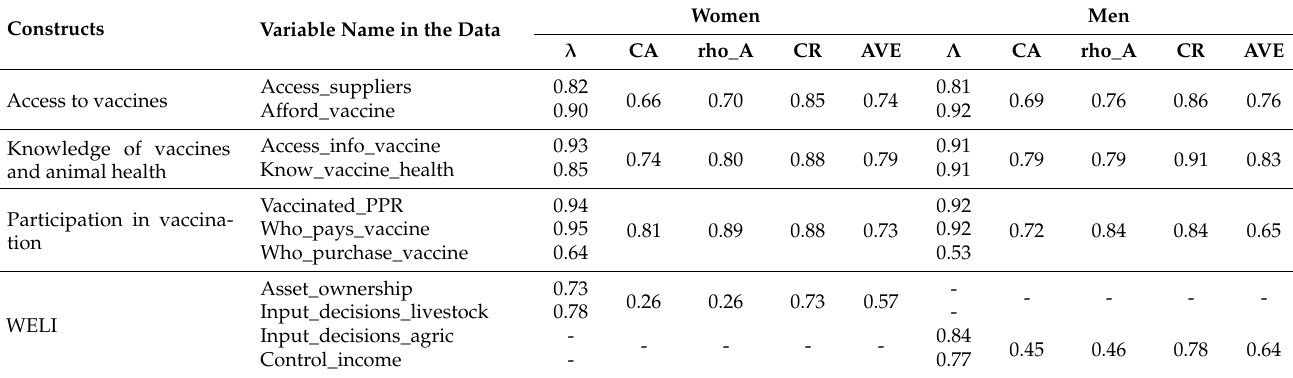
Table 3. Reliability and validity